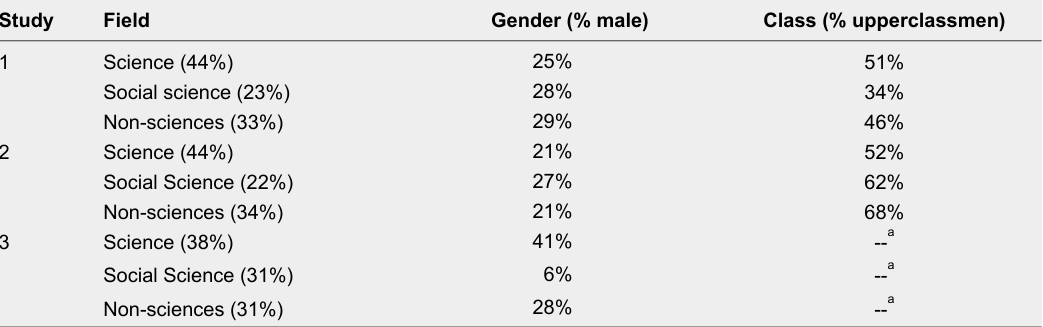
Breakdown of participants for studies by field, gender, and